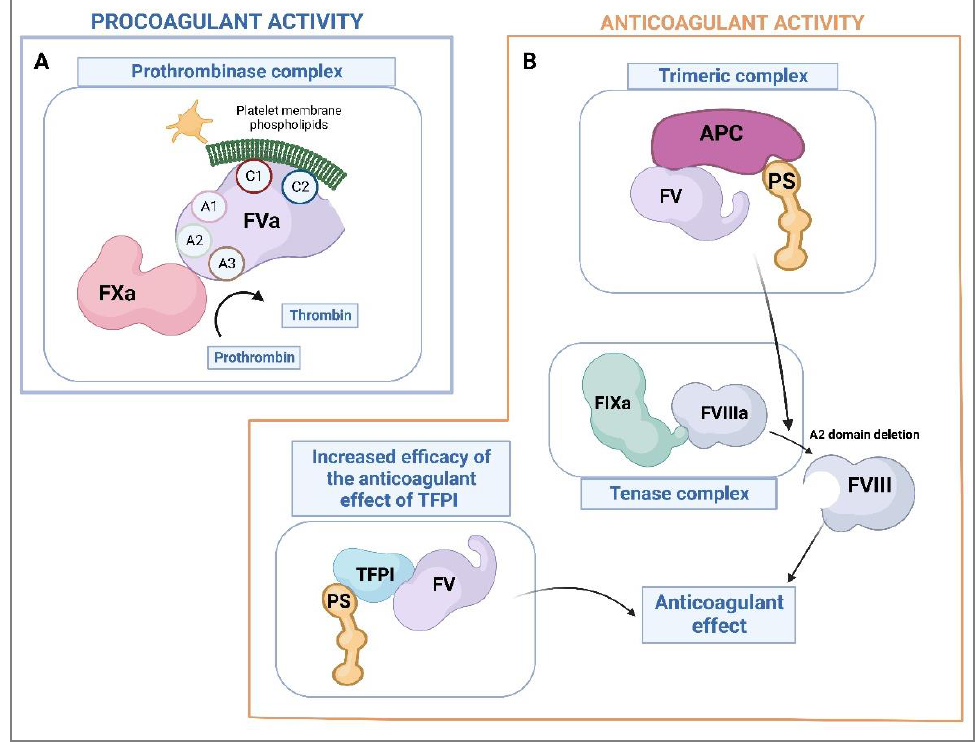
Figure 2. Factor V’s procoagulant and anticoagulant activity. ( A ) Prothrombinase complex-mediated procoagulant activity with thrombin generation. ( B ) Anticoagulant activity mediated by inactivation of the factor VIII component of the tenase complex and by the tissue factor pathway. F, factor; APC, activated protein C; PS, protein S; TFPI, tissue factor pathway inhibitor.